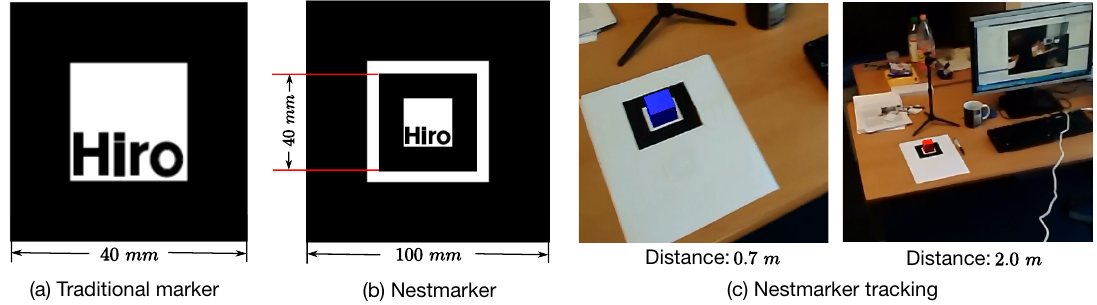
Figure 4. The Nestmarker and its tracking